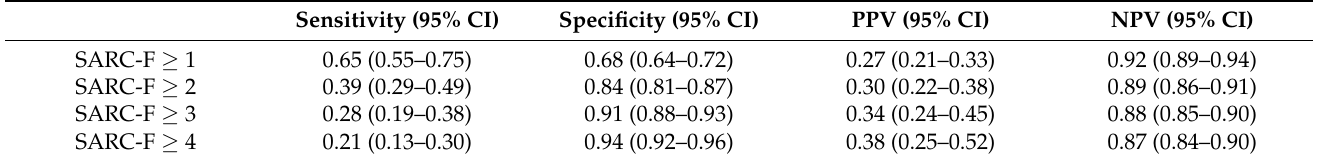
Table 4. Sensitivity, specificity, and positive and negative predictive values for